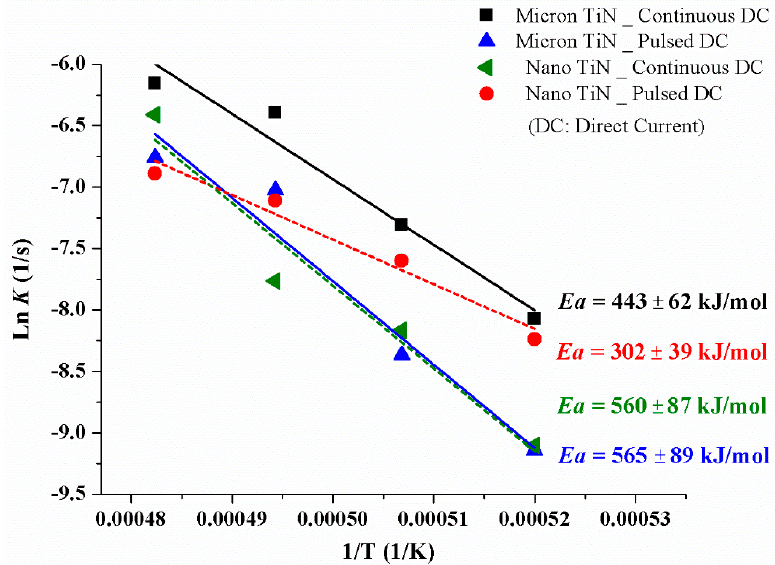
Figure 4. Arrhenius plot of values of the rate constant, K , for the α -to- β phase conversion of the Si 3 N 4 matrix during isothermal holds, for Si 3 N 4 -20 vol % TiN samples sintered in the temperature range of 1650–1800 ◦